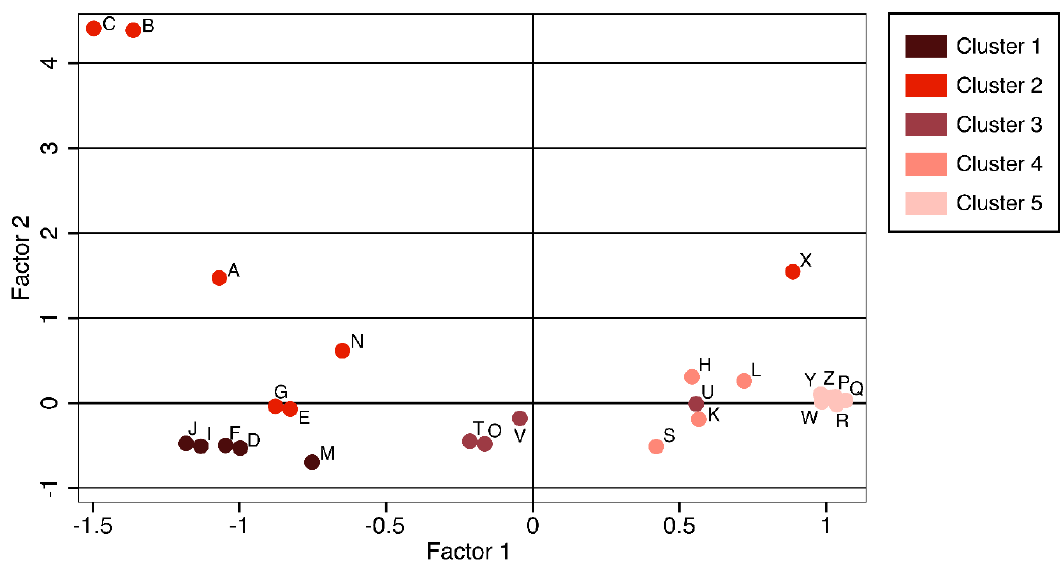
Figure 3. Scores of the pathotypes and their positions relative to the first two factors. Clusters are identified by different colours.